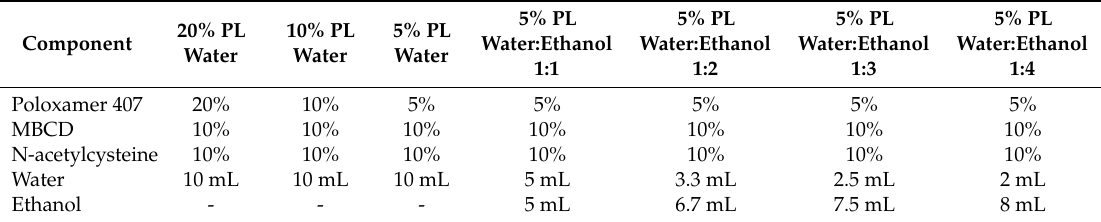
Table 1. Composition of the lacquers used in this work. Quantities are expressed in % w / v for 10 mL of